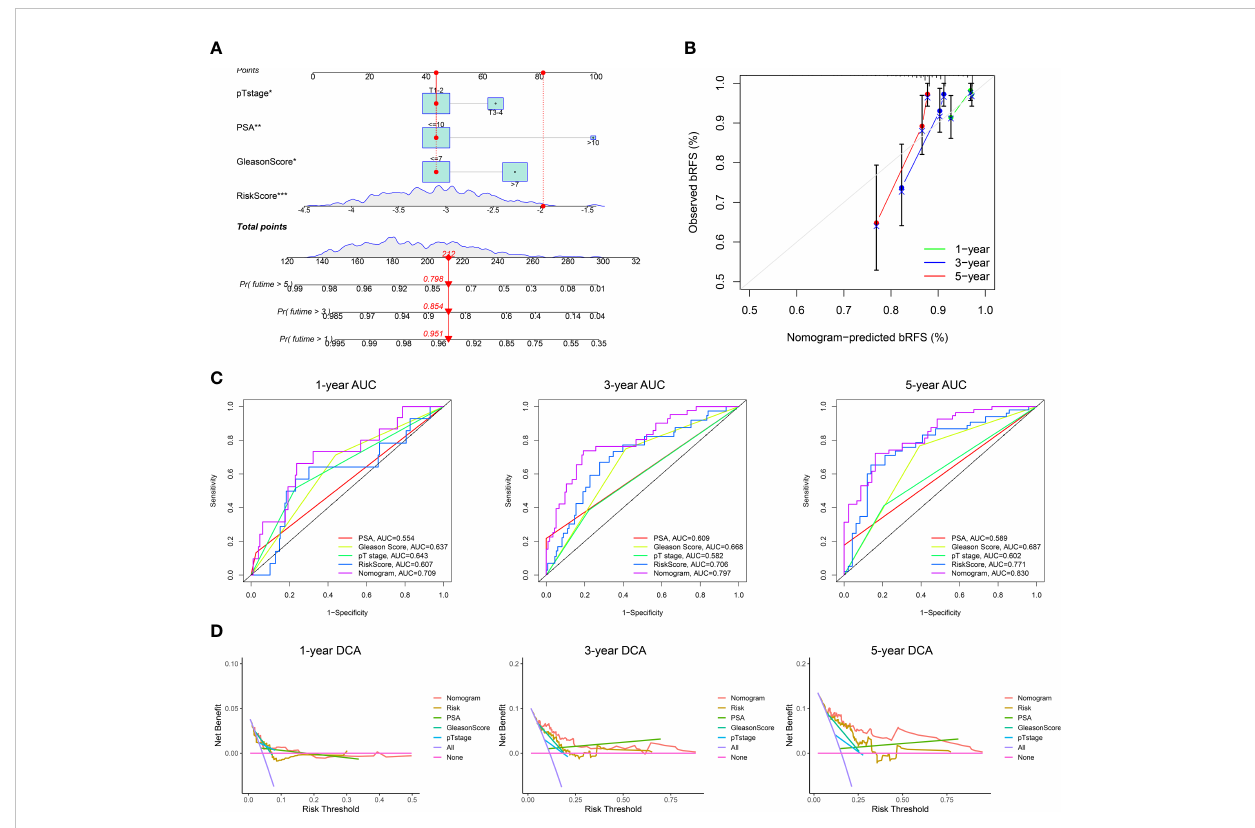
FIGURE 6 Construction of a nomogram in TCGA cohort. (A) The nomogram based on risk score, pT stage, PSA, and Gleason Score. (B) Calibration curves for the internal veri fi cation in 1-, 3-, and 5-year bRFS of the nomogram. (C) ROC curves for the predictive ef fi ciency in 1-, 3-, and 5-year bRFS of the nomogram. (D) DCA curves for the net bene fi t in 1-, 3-, and 5-year bRFS of the nomogram. DCA, decision curve analysis; * P < 0.05, ** P < 0.01, *** P <